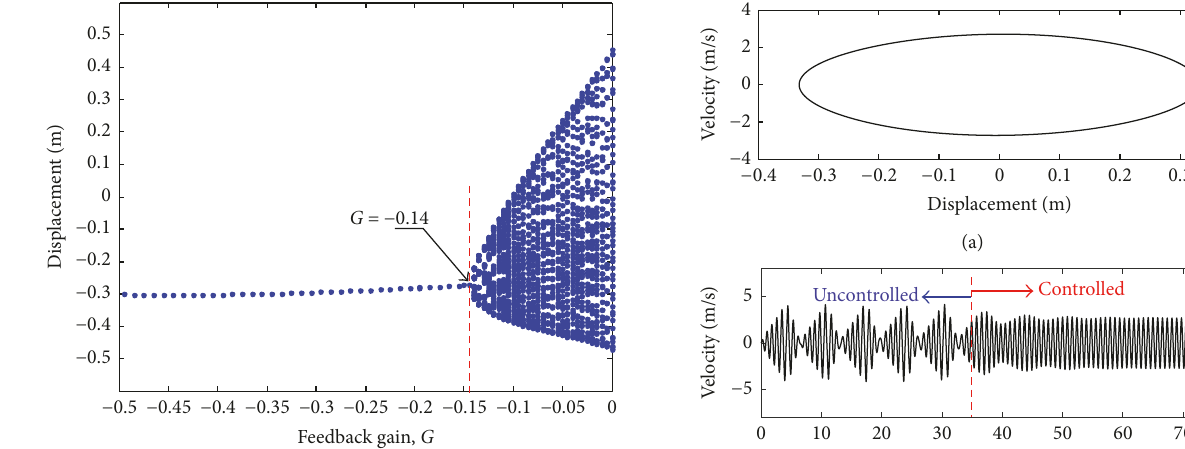
Figure 16: The bifurcation diagram for a system with state feedback control, where 𝐺 denotes the feedback gain.